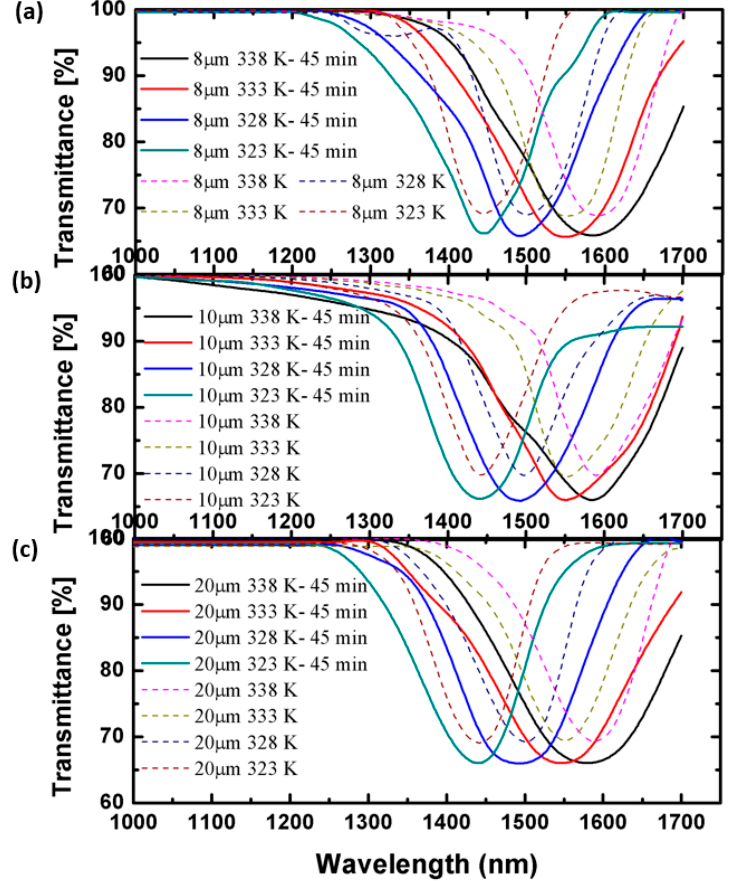
Figure 6. Transmission spectra of PSCLC filters with different cell gaps of ( a ) 8 μ m, ( b ) 10 μ m, and ( c ) 20 μ m. The cells with a holding treatment were held at different temperatures for 45 min and polymerized at 323 K.